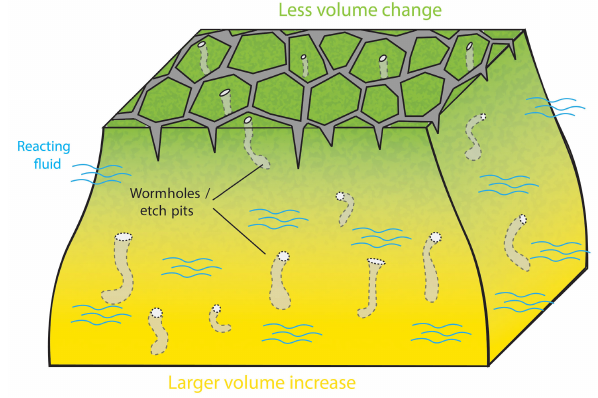
Figure 15. Illustration of porosity generation mechanisms during the olivine carbonation reactions. A combined mechanism of sur- face cracking and the dissolution channelization plays an important role in the porosity generation. Heterogeneity in the microstructure of the material would cause non-uniform distribution of precipita- tion. This would lead to the generation of surface cracking via vol- ume mismatch and generate secondary porosity. Dissolution also produces pore spaces and fluid pathways through etch-pitting chan- nelization which makes the grains susceptible to the cracking on a longer